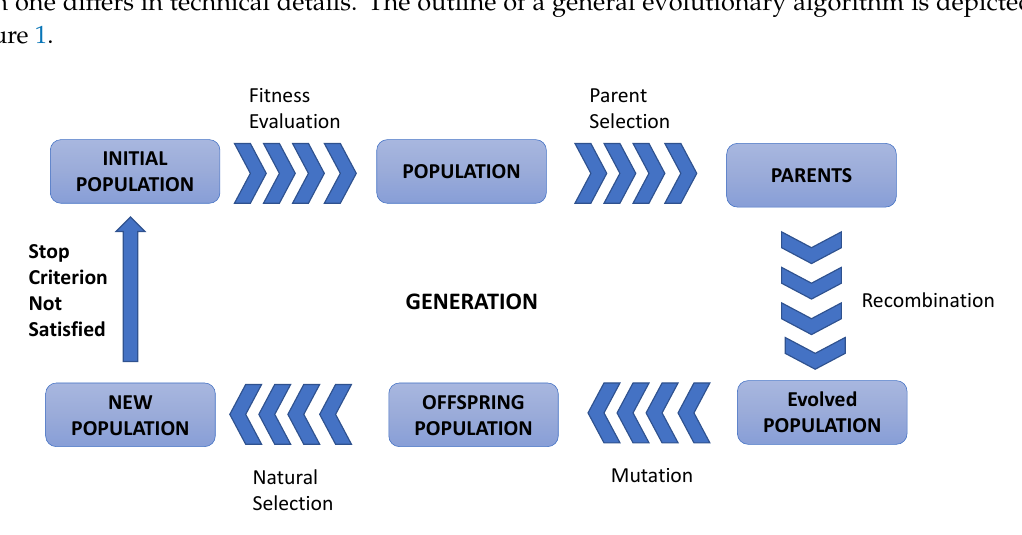
F i gure 1. Outline of a general evolutionary computing algorithm. Figure 1. Outline of a general evolutionary computing